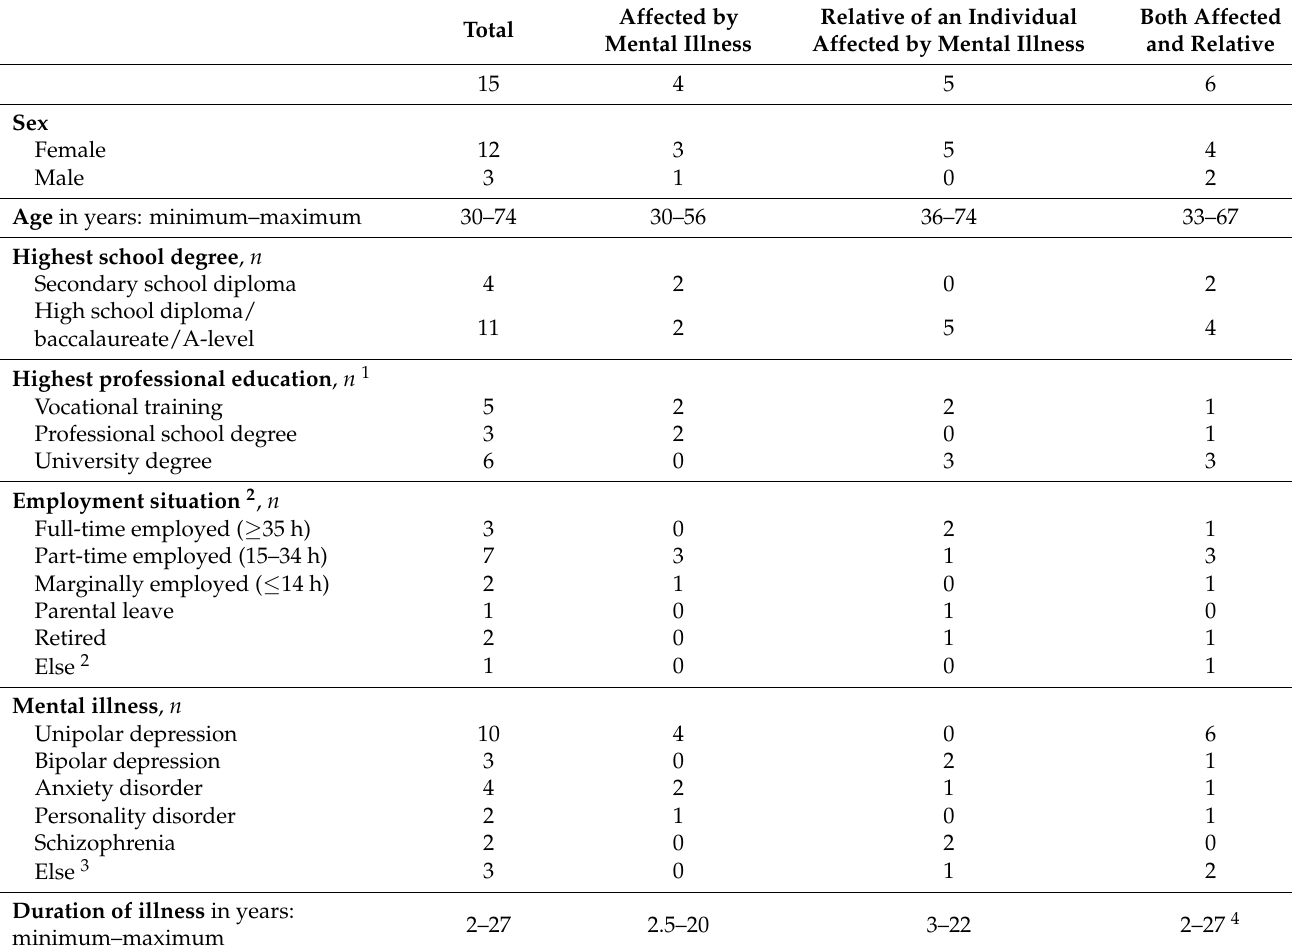
Table 1. Description of sociodemographic and disease-related characteristics of